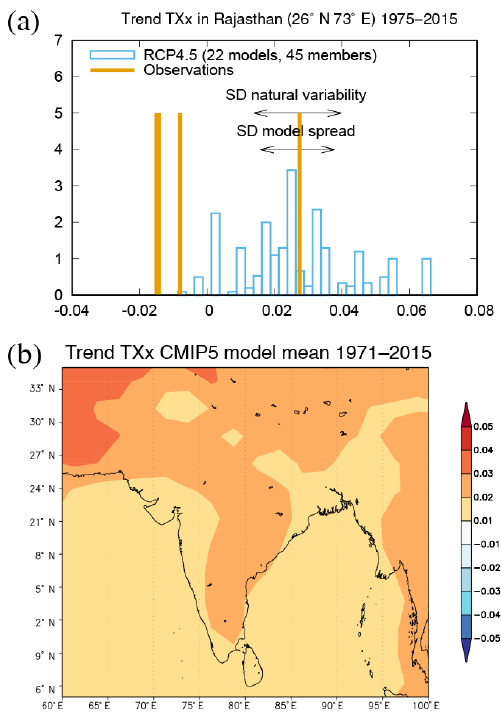
Figure 10. (a) Histogram of the trend in TXx (Kyr − 1 ) at the grid point closest to 26 ◦ N, 73 ◦ E in the CMIP5 ensemble (excluding the MIROC models). Ensemble members of the same model are down- weighted so that each model gets a weight of 1. This is compared with observations: the trends in Bikaner (corrected for varying miss- ing data), Jodhpur and the nearest grid point of the ERA-Interim reanalysis (left three bars). For reference the trend in the IMD grid- ded dataset without correction for varying missing data is also given (rightmost bar). (b) Mean of trend in TXx (Kyr − 1 ) in the CMIP5 ensemble 1971–2015, with historical experiments up to 2005 ex- tended with the RCP4.5 2006–2016 simulations.